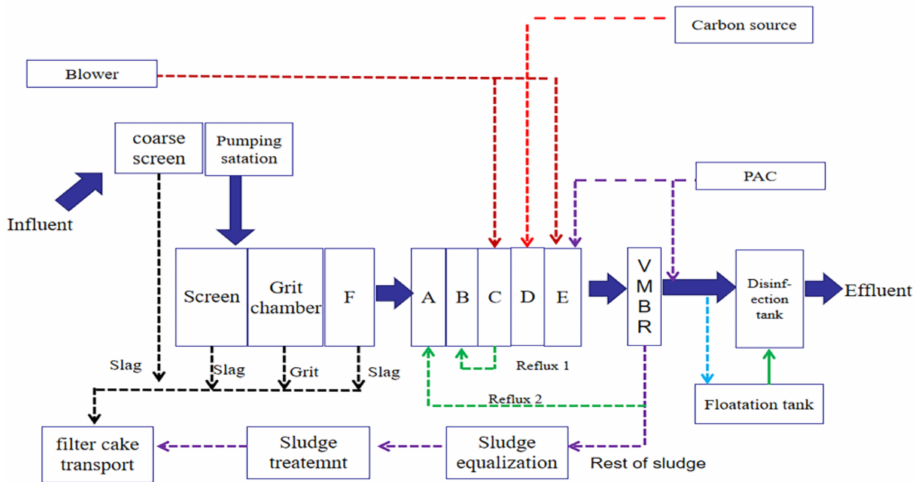
Figure 3. Technology process for municipal treatment. (A, B, C, D, E, and F represent anaerobic, pre-anoxic, oxic, post-anoxic, and post-oxic tanks, and membrane screen,